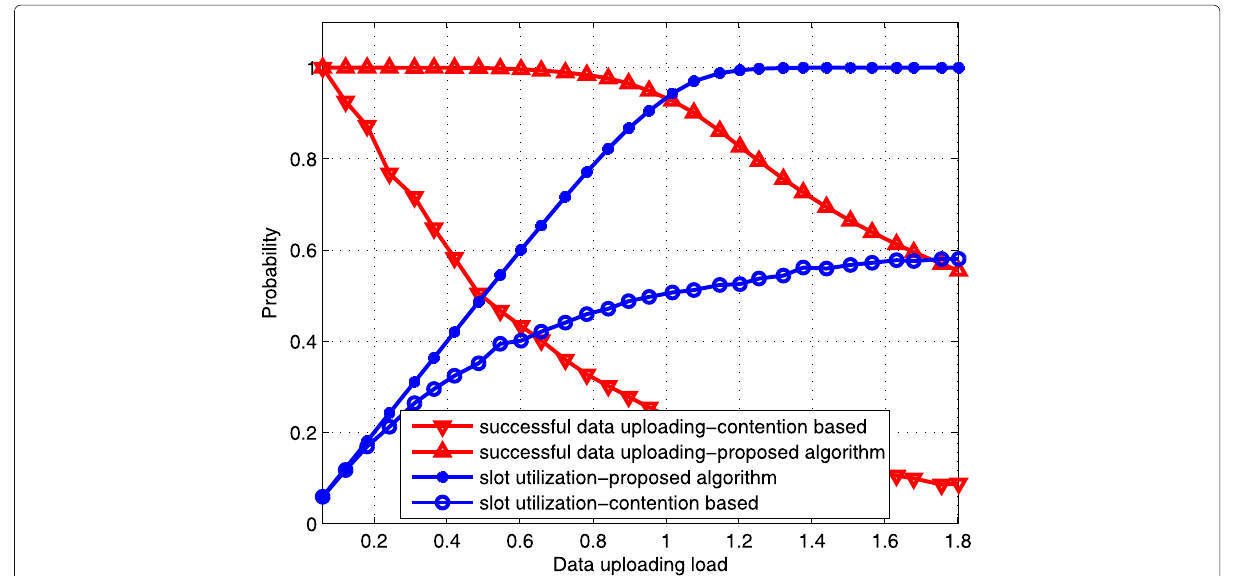
Fig. 3 The probability of successful data uploading and slot utilization of AP j. Performance comparison between our algorithm and the contention-based algorithm in terms of the successful data uploading probability and the slot utilization probability